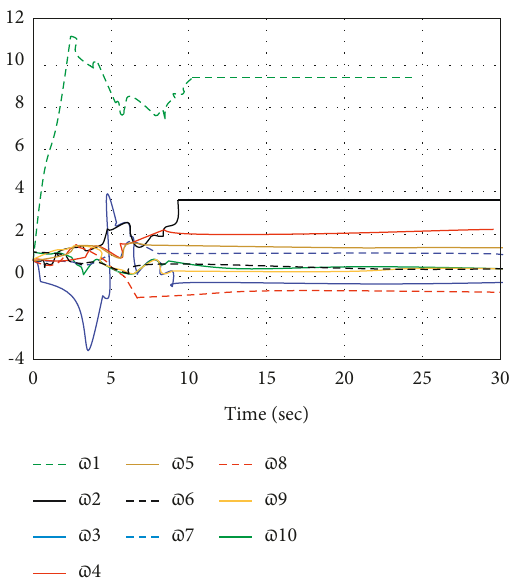
Figure 8: Convergence trajectory of 􏽢 w